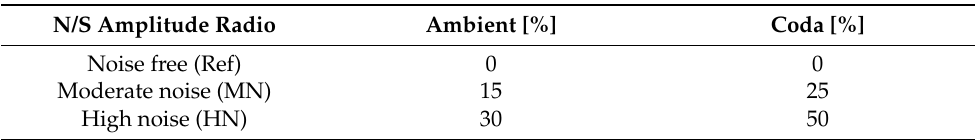
Figure 17. Vertical component (Z) for the three experiments showing the free noise data ( left ), MN data ( center ) and HN ( right ). We can notice that for the HN case, the fault scattered field is completely covered by the coda noise. Table 4. The two noise parameters, ambient and coda, used in the noise study. The reference experiment is experiment 5 (Table